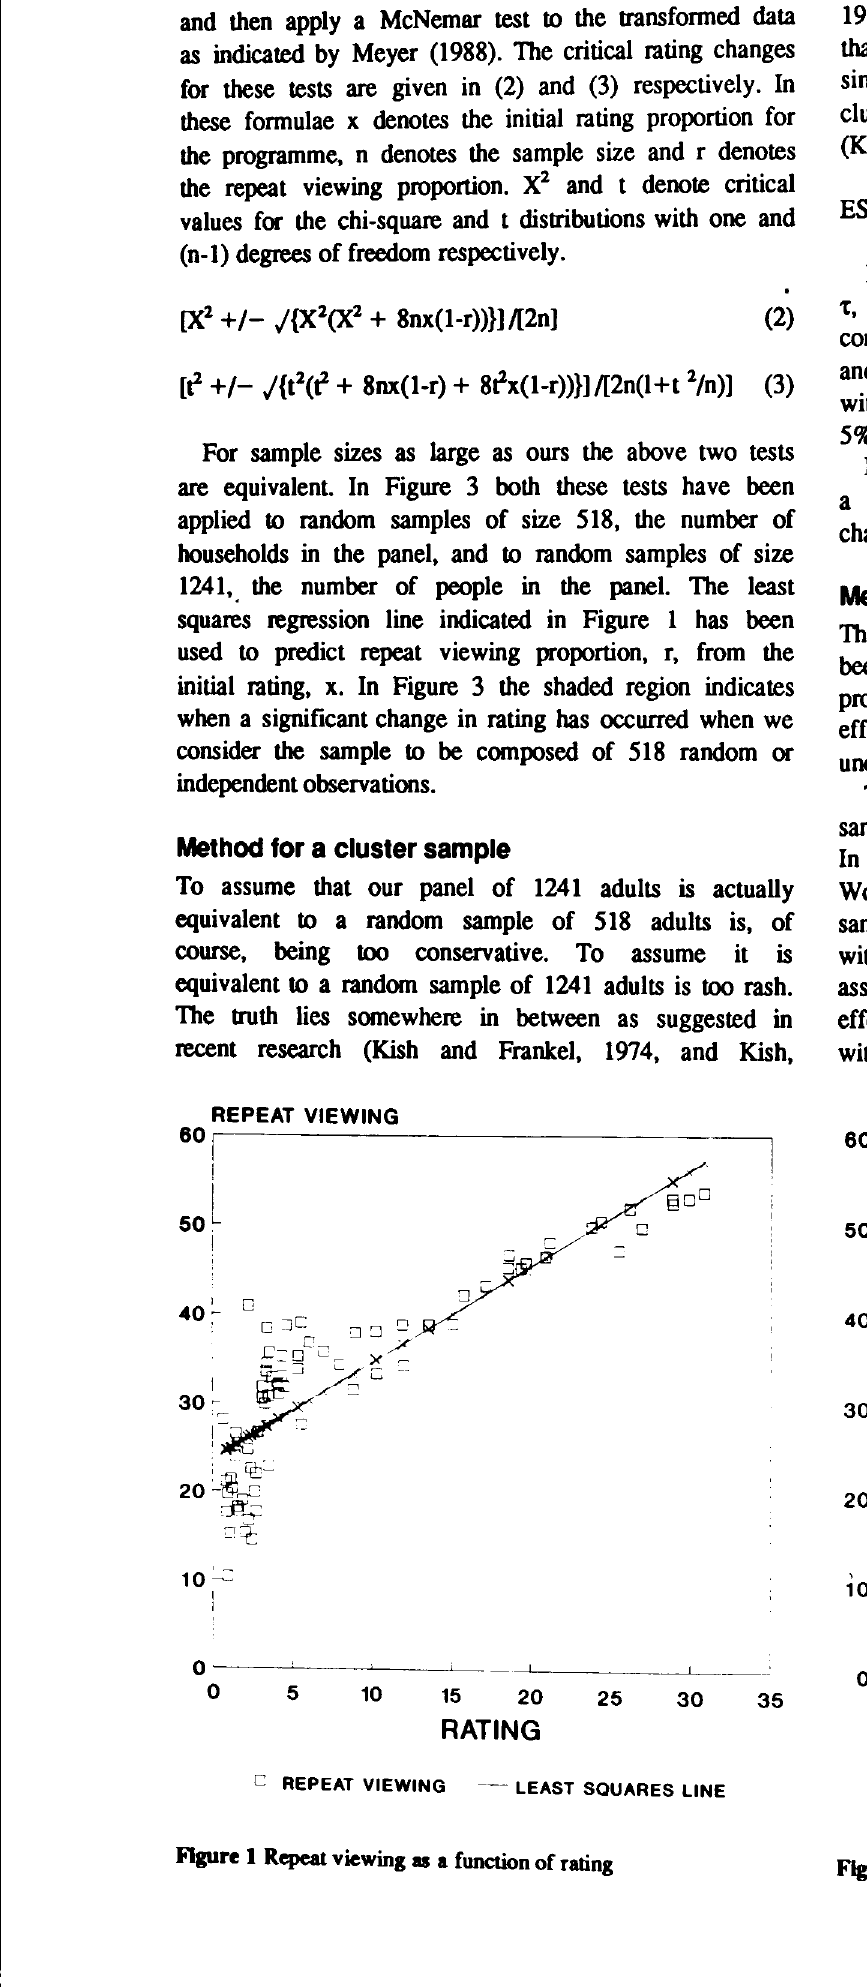
LEAST SQUARES LINE LEAST SQUARES LINE Flpre 2 Social viewing as a function of rating